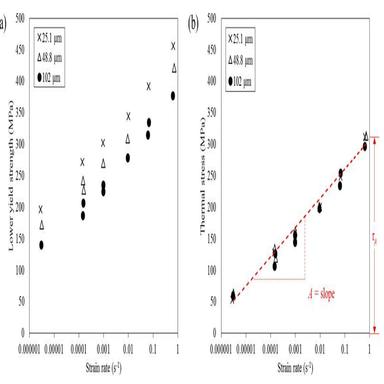
(a) Lower yield stresses for various grain sizes at 195 K and (b) estimation of thermal stress fitted parameters by deduction of grain boundary, dislocation and interstitial solid solution strengthening contributions from lower yield stress at 195 K.